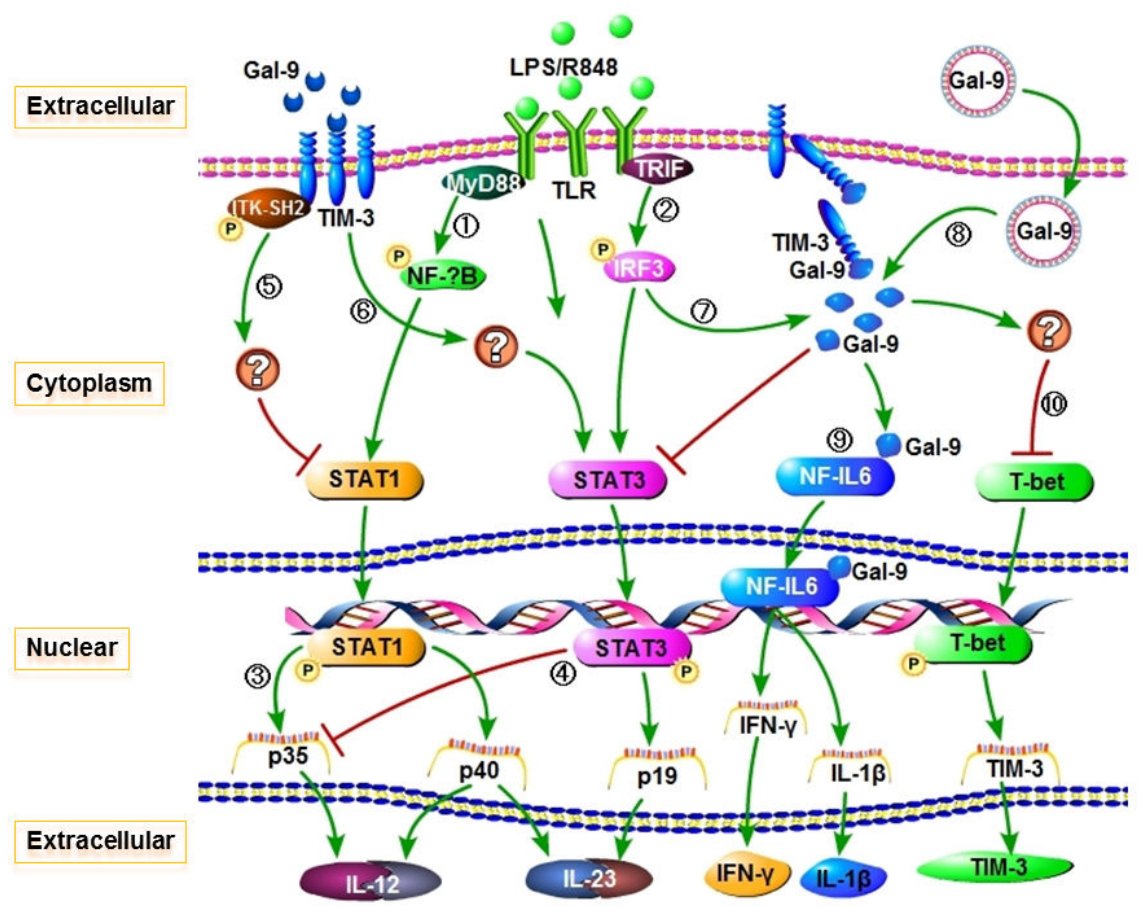
Figure 6. Proposed model for extracellular/intracellular Gal-9 trans and cis association with Tim-3 in regulation of monocyte inflammatory cytokine expressions through TLR signaling. After binding pathogenic products, TLR signaling involves cross-linking of adapter proteins, such as MyD88 (1) and TRIF (2), activation of NF B-dependent/-independent (IRF3) К pathways, and phosphorylation of multiple signaling molecules, including STAT-1 and STAT-3. Phosphorylated STAT-1 activates transcription/translation of IL-12 (3); whereas STAT-3 phosphorylation activates IL-23 but inhibits IL-12 expressions (4). In the case of chronic infections (such as HCV and HIV), pathogens may up-regulate Tim-3 expression on M/M and Gal-9 expression by other Φ cells, facilitating Tim-3/Gal-9 trans - association and so impairing innate immune responses. More specifically, extracellular Gal-9 trans association with Tim-3 expressed on the surface of M/M , triggers Tim-3-SH2 tyrosine (Y265) phosphorylation by interleukin Φ inducible T cell kinase (ITK), delivering negative signaling to TLR-mediated STAT-1 phosphorylation (5), and positive signaling to TLR-induced STAT-3 activation (6), resulting in inhibition of IL-12 but promotion of IL-23 productions. Imbalanced IL-23/IL-12 favors the differentiation of T 2, TH17, and Treg cells that contribute to the development of chronic infection and autoimmune disorders. In H the case of acute infection (such as self-limited HCV), TLR signaling may activate Gal-9 and Tim-3 cis association within the same M/M (7) and yield adequate inflammatory cytokine expressions. Moreover, intracellular Gal-9 expressions can modulate M/M Φ Φ Tim-3 and IL-12/IL-23 gene transcriptions (8). Upon TLR stimulation, intracellular Gal-9 rapidly translocates into nuclei, binds to NF- IL6 but not NF B, and triggers IL-1β and IFN-γ transcriptions 31 (9). Intracellular Gal-9 also inhibits STAT3 but not STAT-1 К phosphorylation, leading to increased IL-12 and decreased IL-23 gene transcriptions. However, intracellular Gal-9 appears to reduce Tim-3 cell surface expression by two distinct mechanisms: cis association/internalization and transcriptional inhibition, through a STAT-3-independent but possibly T-bet-dependent pathway (10). Appropriate TLR signaling in innate immune cells may thus facilitate proper adaptive immune responses to successfully clear the acute infection. Based on this schematic model, therapeutic strategies manipulating Tim-3/Gal-9 trans and/or cis association might be of clinical benefit.